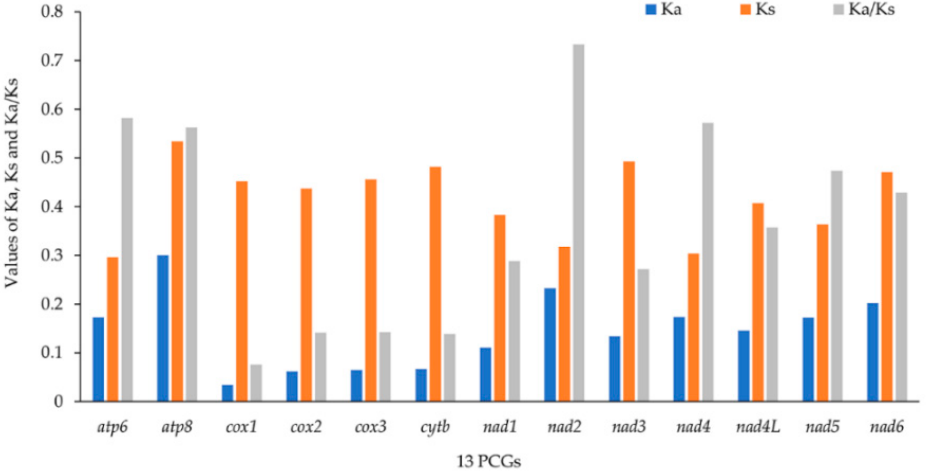
Figure 3. The Ka (the number of non-synonymous substitutions per nonsynonymous site), Ks (the number of synonymous substitutions per synonymous site) and Ka/Ks values of protein-coding genes within Pentatominae.